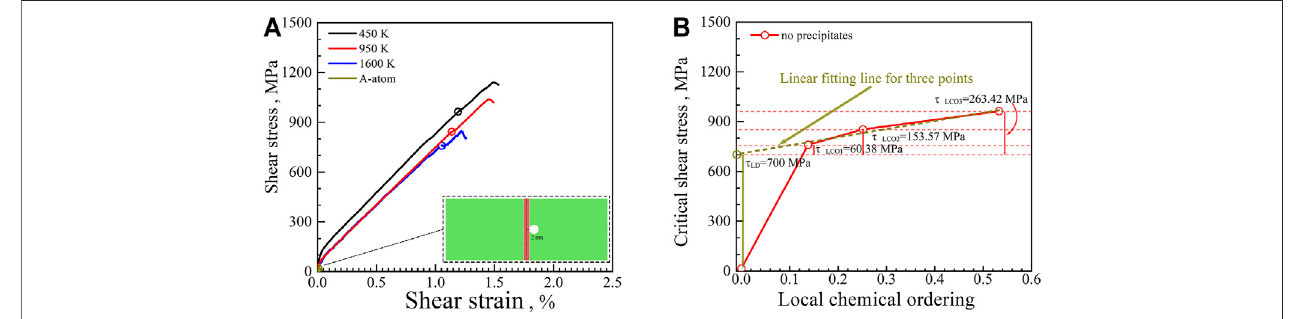
FIGURE 2 | (A) Simulated shear stressstrain curves for the samples with various degrees of local chemical ordering and for the sample simulated by the A-atom potential (without nanoprecipitates). (B) The reference shear stress for the edge dislocation moving with a displacement of 2 nm as a function of the degree of local chemical